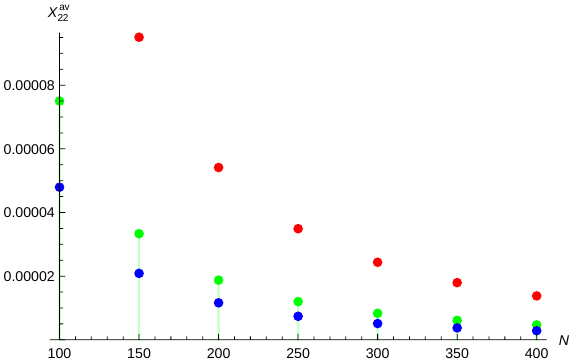
Figure 5 . Plot for k = 2. Red dots show X av [0 ; 0 : 0000965] plotted against N . Green dots represent X KZ